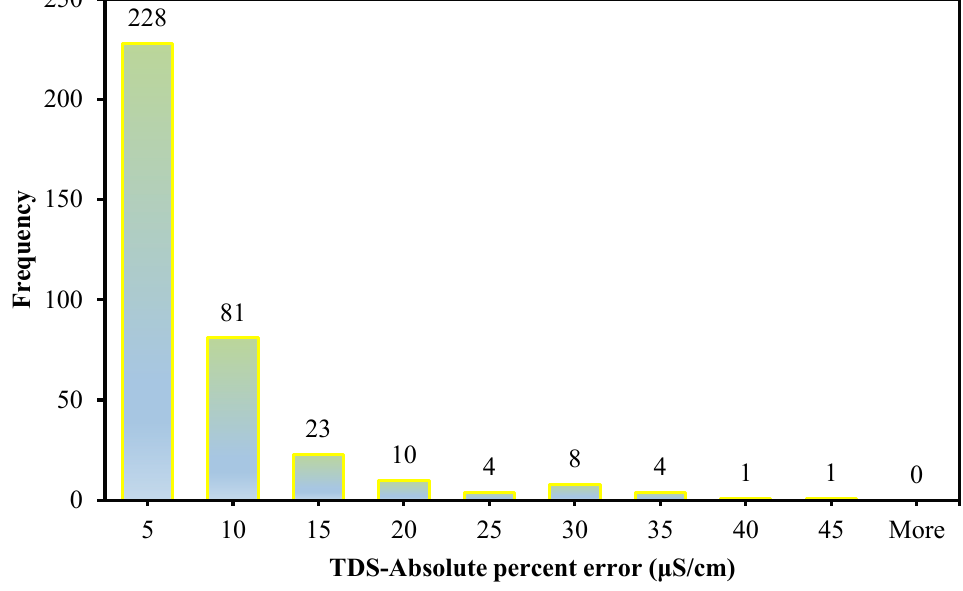
Figure 7. Histogram representing the percent error ranges of MEP-TDS model.